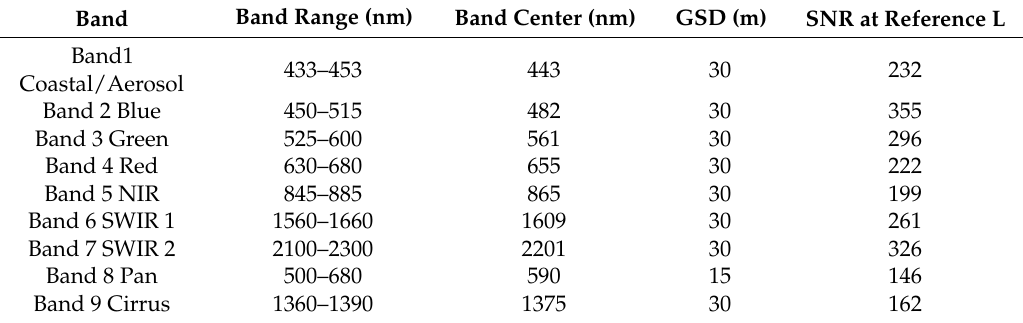
Table 1. Bands of the OLI (Operational Land Imager) on Landsat-8, with band range, band